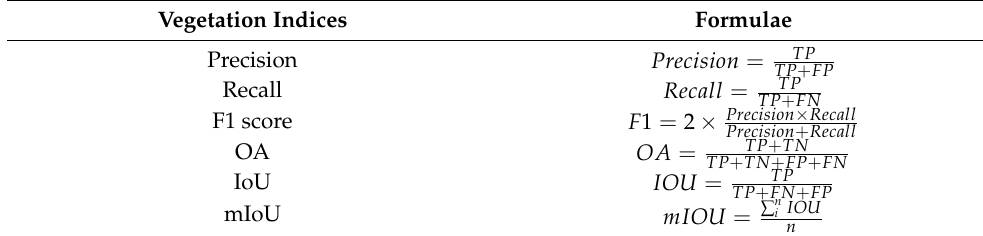
Table 3. Evaluation indicators and formulae.